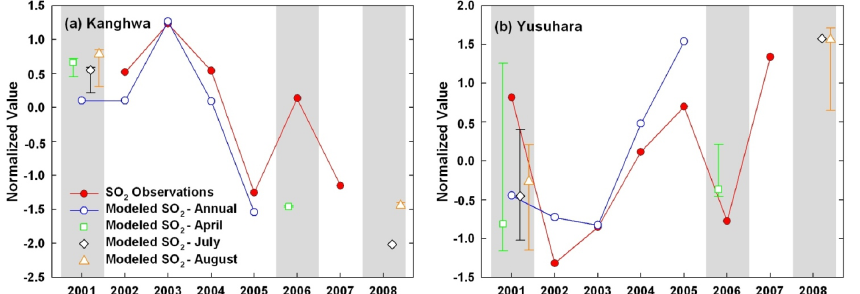
Fig. 13. Normalized inter-annual trends of modeled and observed SO 2 concentrations from 2001 to 2008 at (a) Kanghwa site in South Korea and (b) Yusuhara site in Japan. The annual model results are obtained from the runs with constant emission (TRACE-P). The markers at years 2001, 2006, and 2008 (as indicated in the gray areas) represent the simulation results of model runs with emissions targeting the corresponding years. The respective error bars show the ranges of all available model results with the same emissions (see Table 1 for